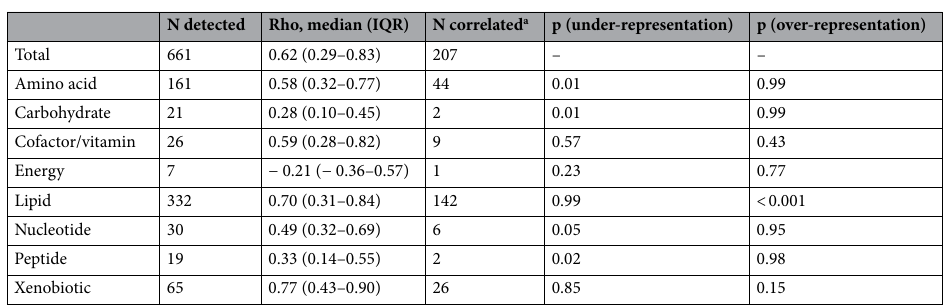
Table 2. Number of compounds detected in ≥ 3 plasma and marrow samples, and number that were significantly correlated after FDR correction, by class. a q < 0.05 after Benjamini–Hochberg correction.